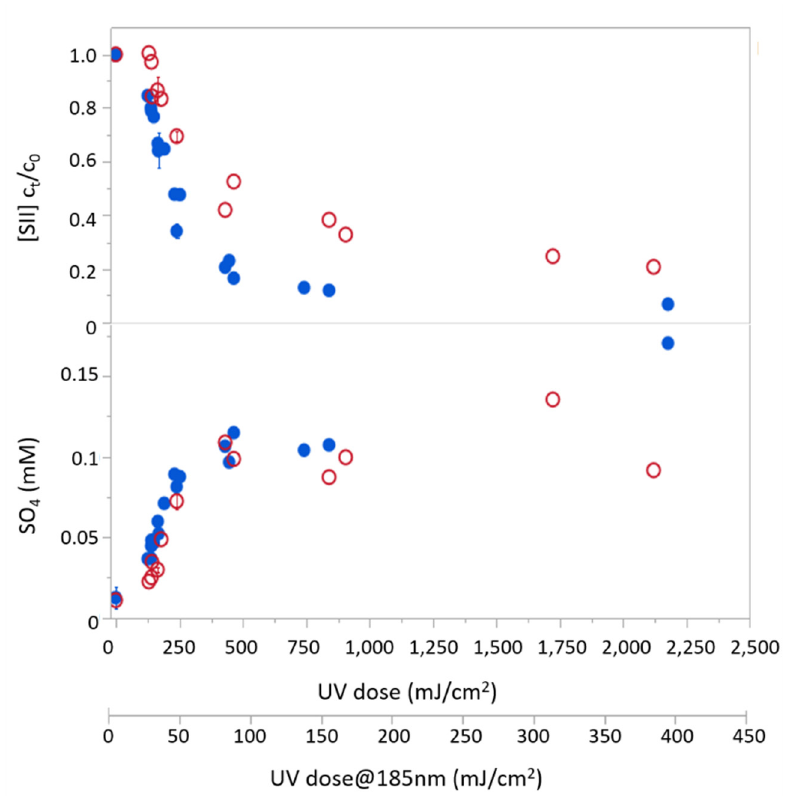
Figure 1. Sulfide degradation (top) and sulfate generation (bottom) using two different lamps: UV-C/VUV (254/185 nm; solid blue circles) and UV-C (254 nm; blank red circles) as a function of UV dose.